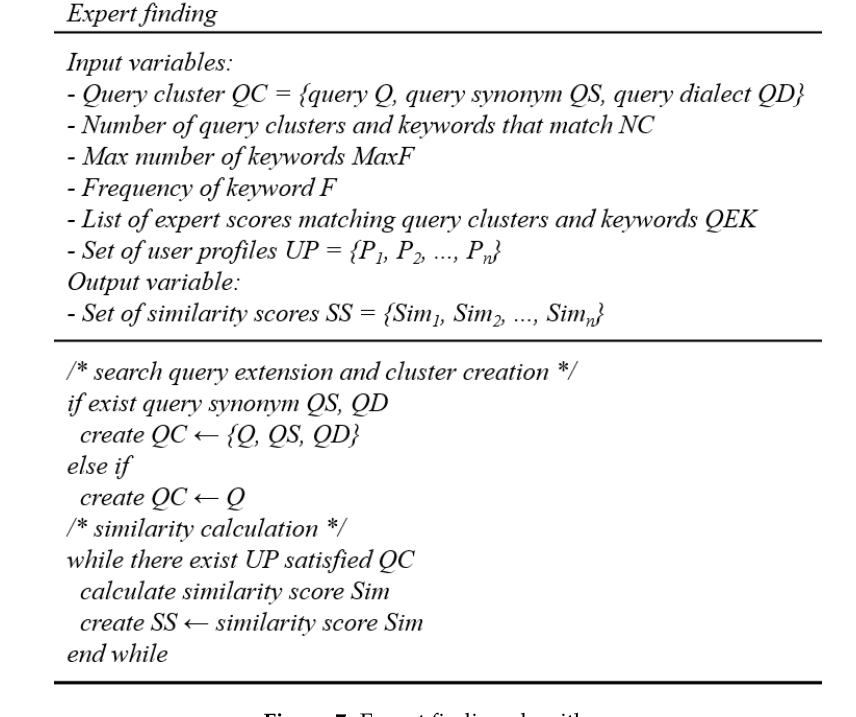
Figure 7. Expert finding algorithm.